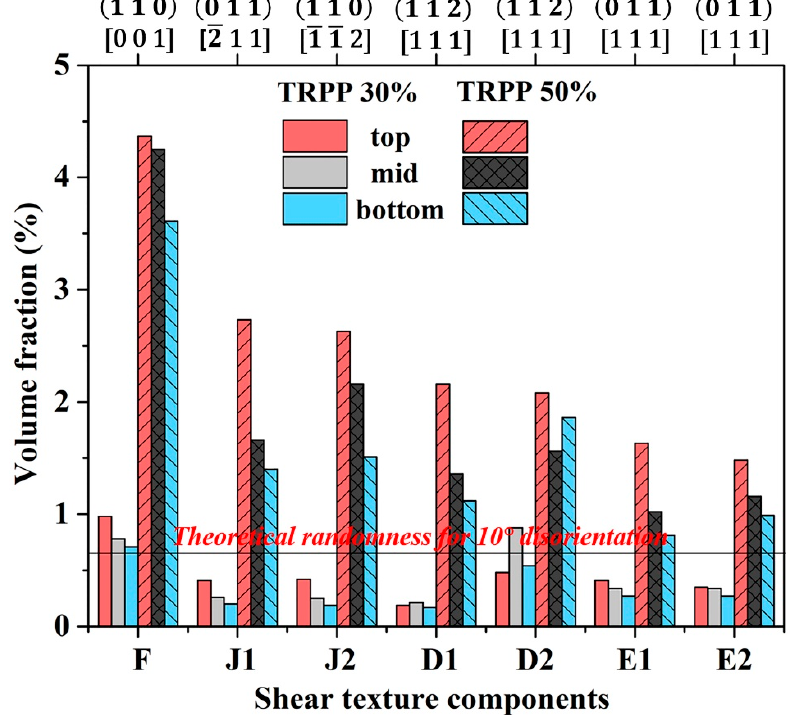
Figure 8. Prominent shear texture components at three locations across the sheet thickness for the asymmetric ratio 1:2 with 30% and 50%